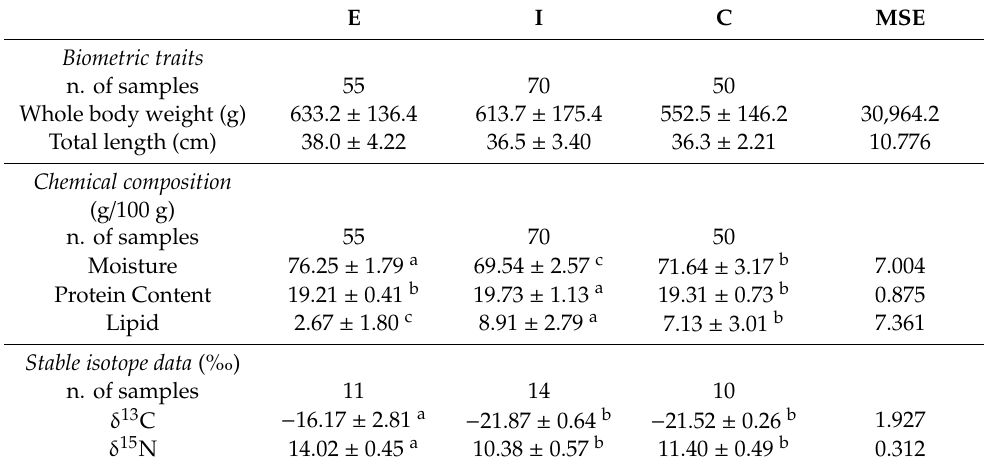
Table 2. E ff ect of the rearing system (E = Extensive; I = Intensive inland; C = Intensive in sea cages) on biometric traits, chemical composition, and δ 13 C and δ 15 N of the muscle of the sea bass. E I C